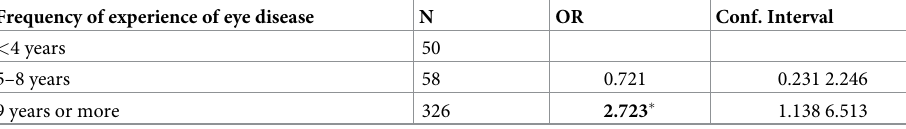
Table 5. Relationship between exposure to smoke and eye